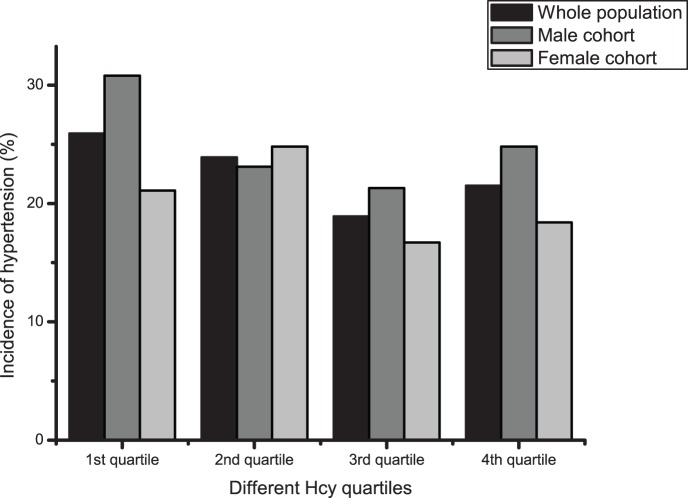
Incidence of hypertension within different Hcy quartiles.Black bar: Whole population; Dark gray bar: Male cohort; Light grey bar: Female cohort.